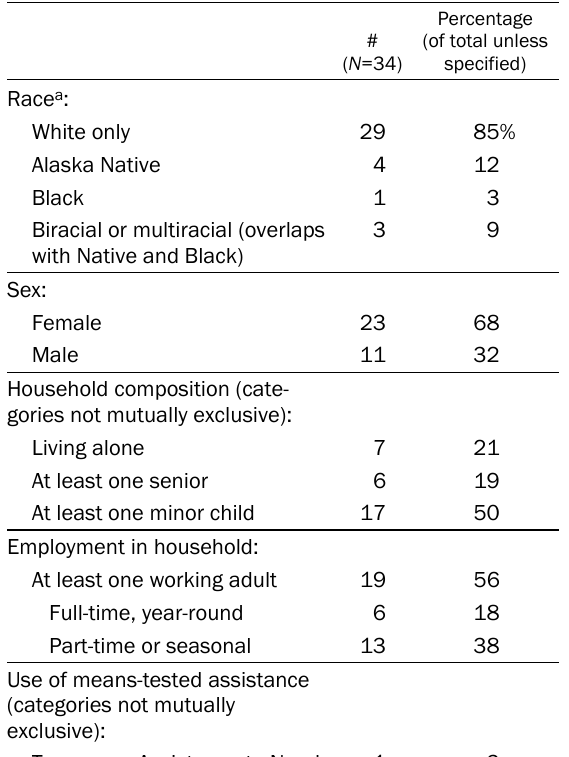
Table 1. Participant and Household